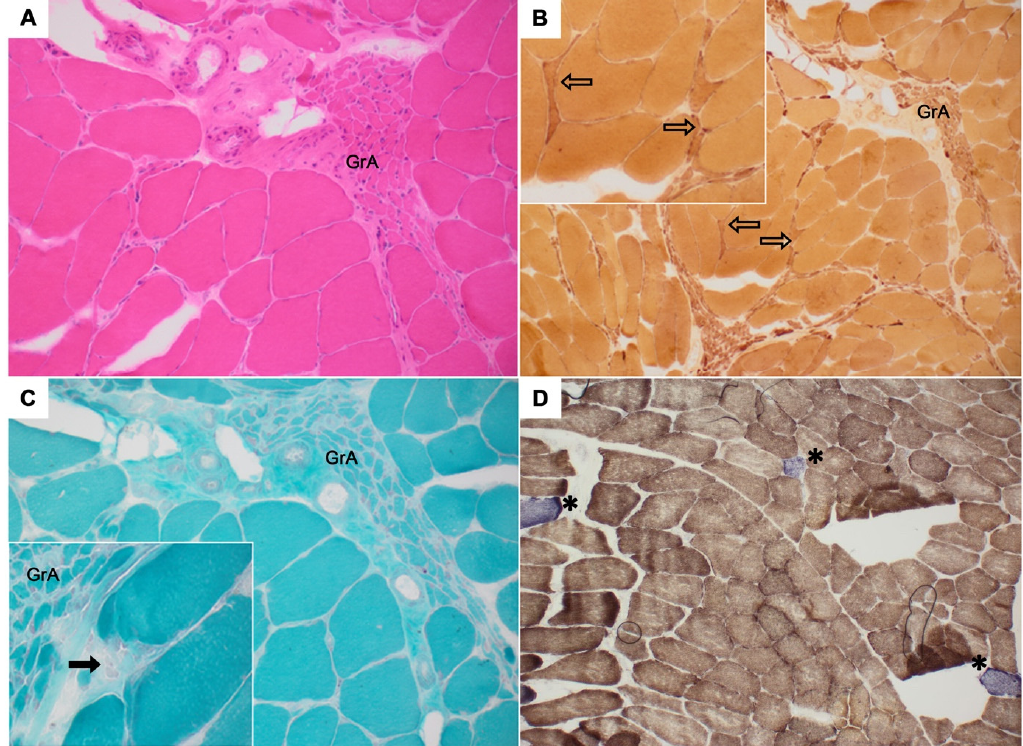
Figure 2. Muscle biopsy of ALS patient VALS054 of cohort 1 diagnosed with the PMA subtype carrying the DHTKD1 :c.209C>G p.(Ala70Gly) variant. Muscle sections were stained using ( A ) hematoxylin-eosin, ( B ) nonspecific esterase, ( C ) modified Gomori trichrome, and ( D ) combined cytochrome c oxidase and succinate dehydrogenase (COX/SDH). Histopathological analysis revealed a distinctive pattern of neurogenic damage including groups of atrophic muscle fibers (GrA), single atrophic mus- cle fibers (unfilled arrows), and scattered muscle fiber necrosis (filled arrows). In the COX/SDH stain, up to six fibers per cross section were COX negative (blue fibers denoted by asterisks), suggesting mitochondrial